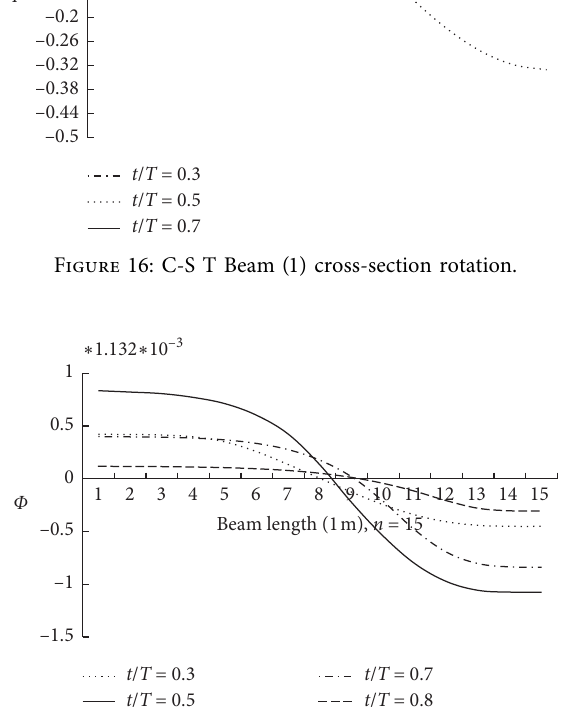
Figure 17: S-S T Beam (3) cross-section rotation.